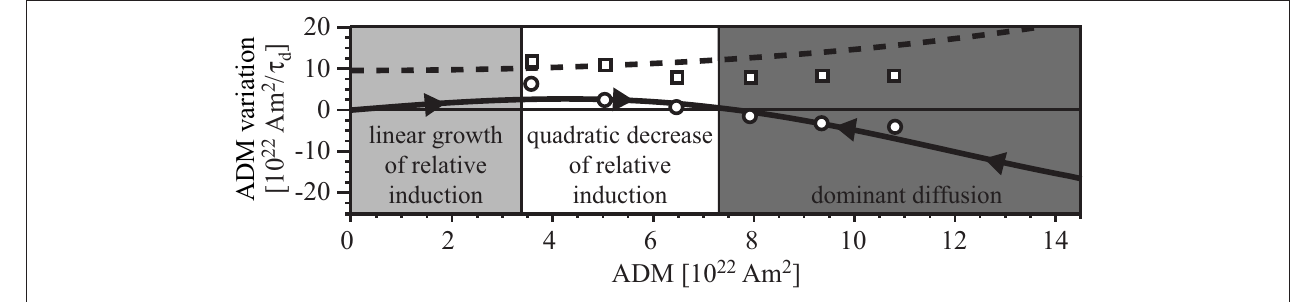
FIGURE 14 | Drift d and rescaled fluctuation f ⋆ for the reversing dynamo model E3R9 (solid and dashed curves respectively) and for the palaeomagnetic model PADM2M (open circles and squares respectively). Colored backgrounds separate the regimes for the different inductive and diffusive contributions found in the